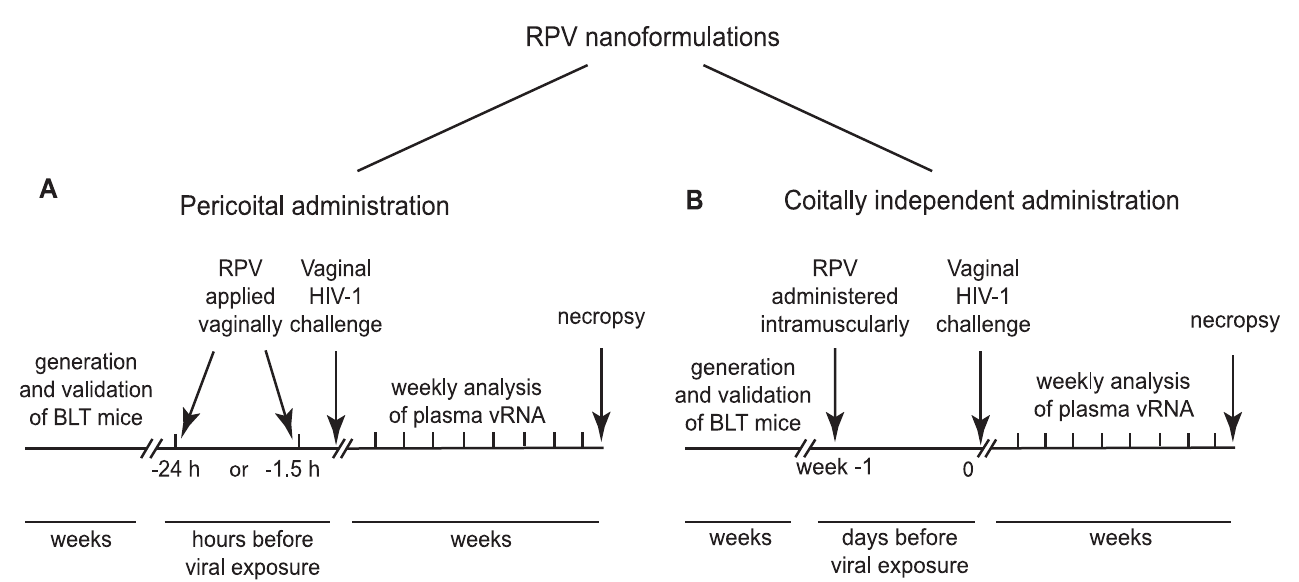
Fig 1. Experimental design for the evaluation of efficacy of RPV nanoformulations in prevention of vaginal HIV transmission in humanized BLT mice. (A) Experimental design for evaluation of efficacy of PLGA nanoparticles loaded with RPV (PLGA/ RPV NPs) in thermosensitive gel as a pericoital PrEP administered as a single topical application 1.5 h or 24 h before HIV-1 challenge. (B) Experimental design for evaluation of efficacy of long acting nanosuspension of RPV administered in a single dose intramuscularly 1 week before HIV-1 challenge, as a coitus-independent approach to prevent vaginal HIV transmission.